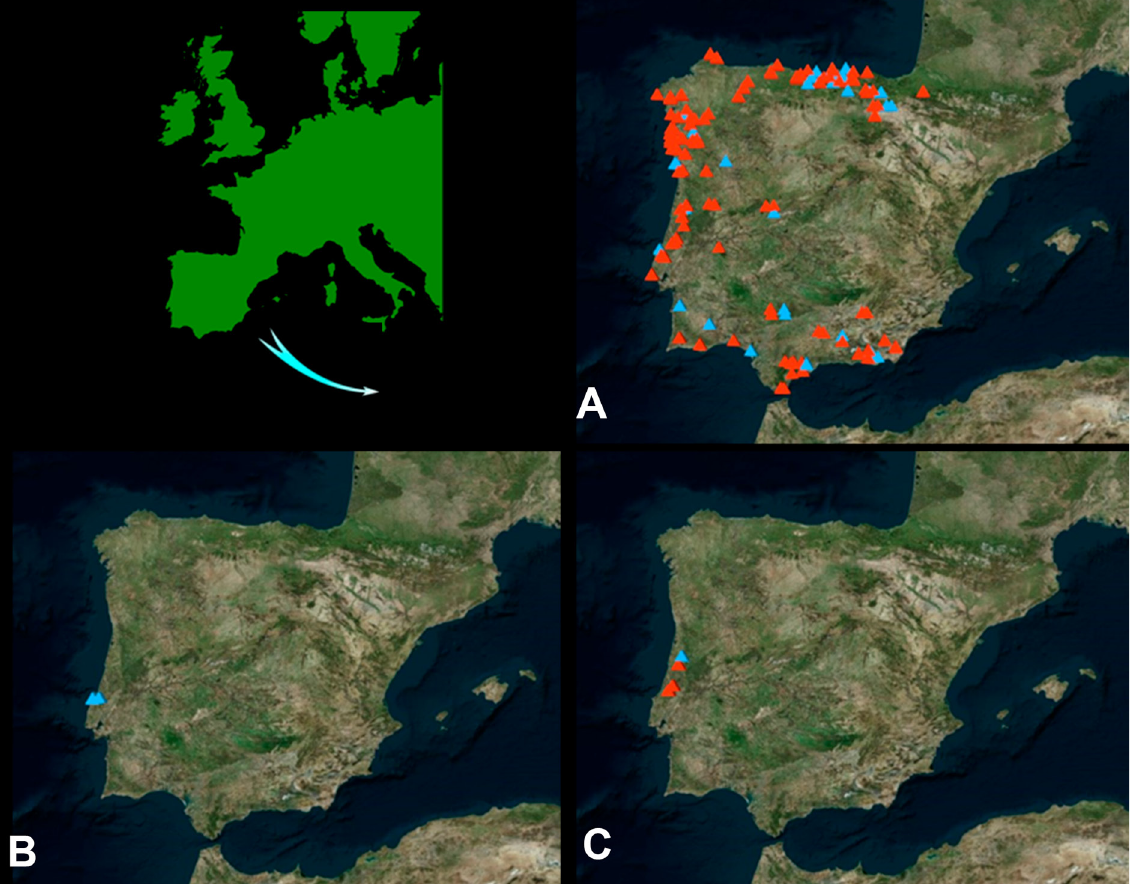
Fig. 1. Map of location of the Iberian Peninsula and maps with the geographic distribution of the species of Eluma (bibliographical references with red triangle; material studied with blue triangle). A . E. caelata (Miers, 1877). B . E. matae sp. nov. C . E. tuberculata Cruz,